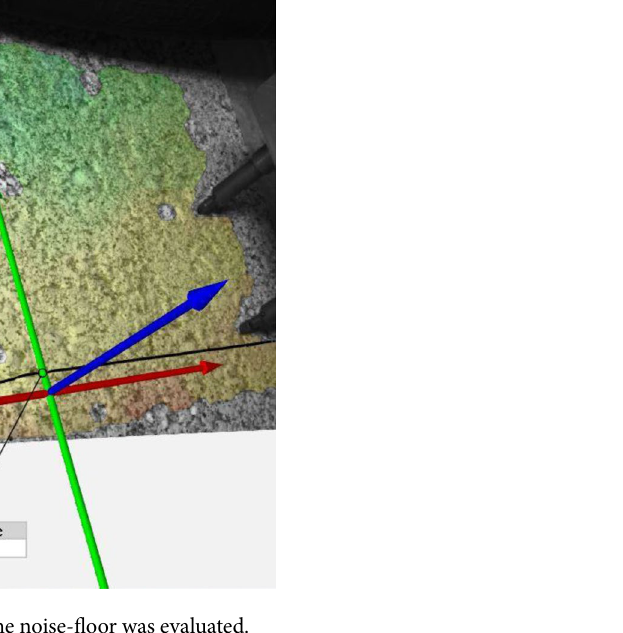
Figure 4. The line across which the noise-floor was